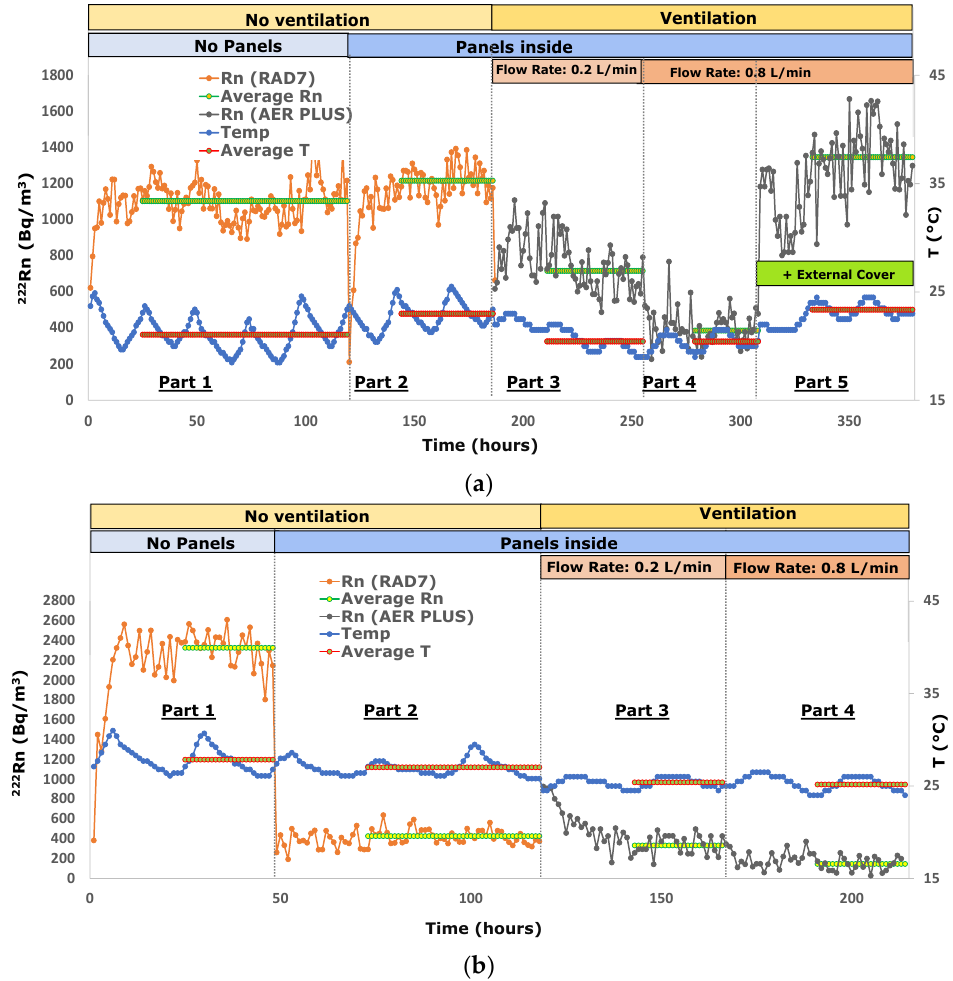
Figure 2. ( a ) Radon activity concentration in the model room during experiments 1 (the plasterboard); ( b ) Radon activity concentration in the model room during experiments 13 (Aquaflex S1K). The relative standard deviation is approximately 40% at 100 Bq m − 3 , approximately 18% at 500 Bq m − 3 and approximately 13% at 1000 Bq m −3 .